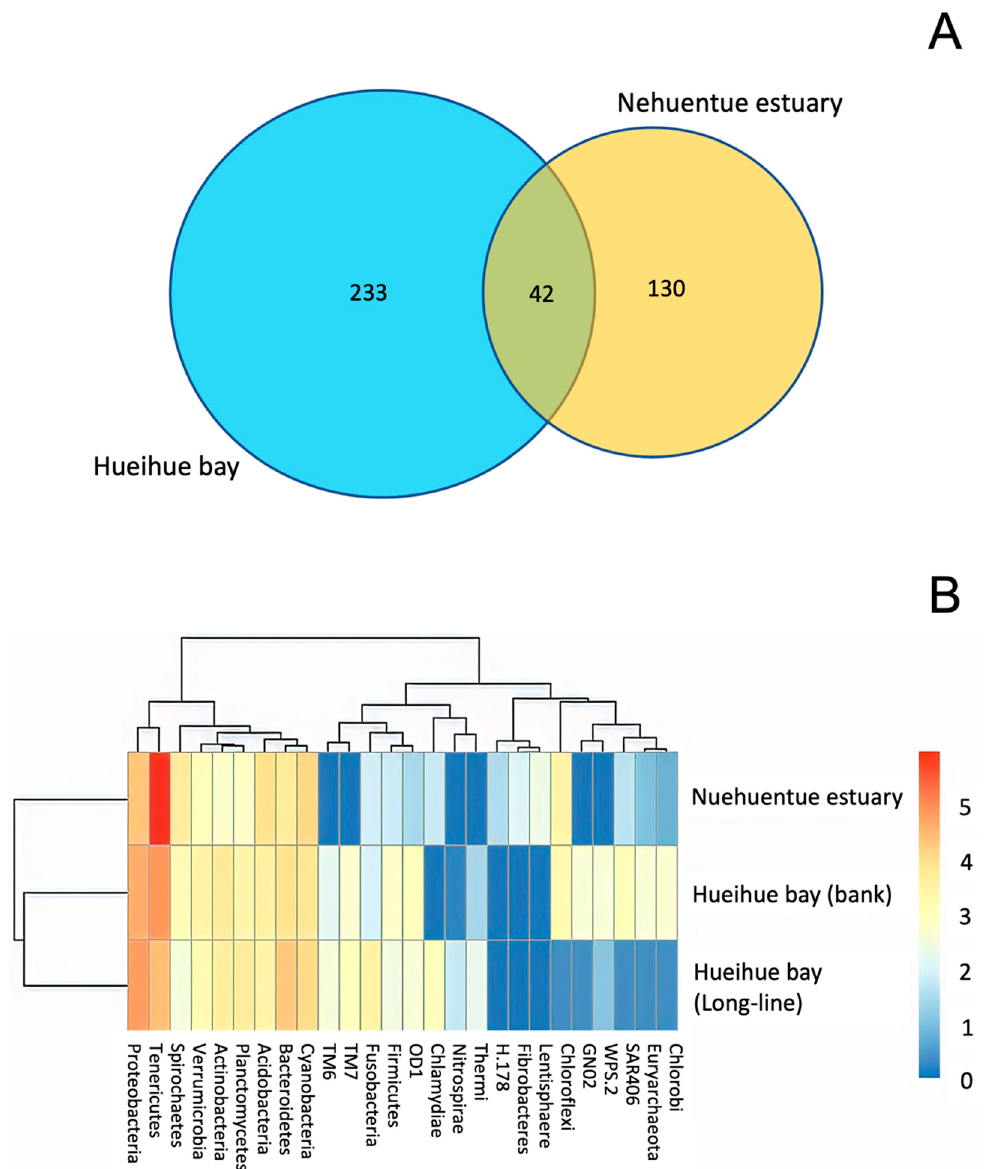
Figure 4. ( A ) Unique and shared OTUs among bacterial communities in tissue samples of Choromytilus chorus specimens grown in Nehuentue Estuary and Hueihue Bay. ( B ) Heatmap showing the taxonomy at the phylum level of bacterial communities in tissue samples of Choromytilus chorus specimens grown in Nehuentue Estuary and Hueihue Bay. The value from 0 to 5 represent log of relative abundance).